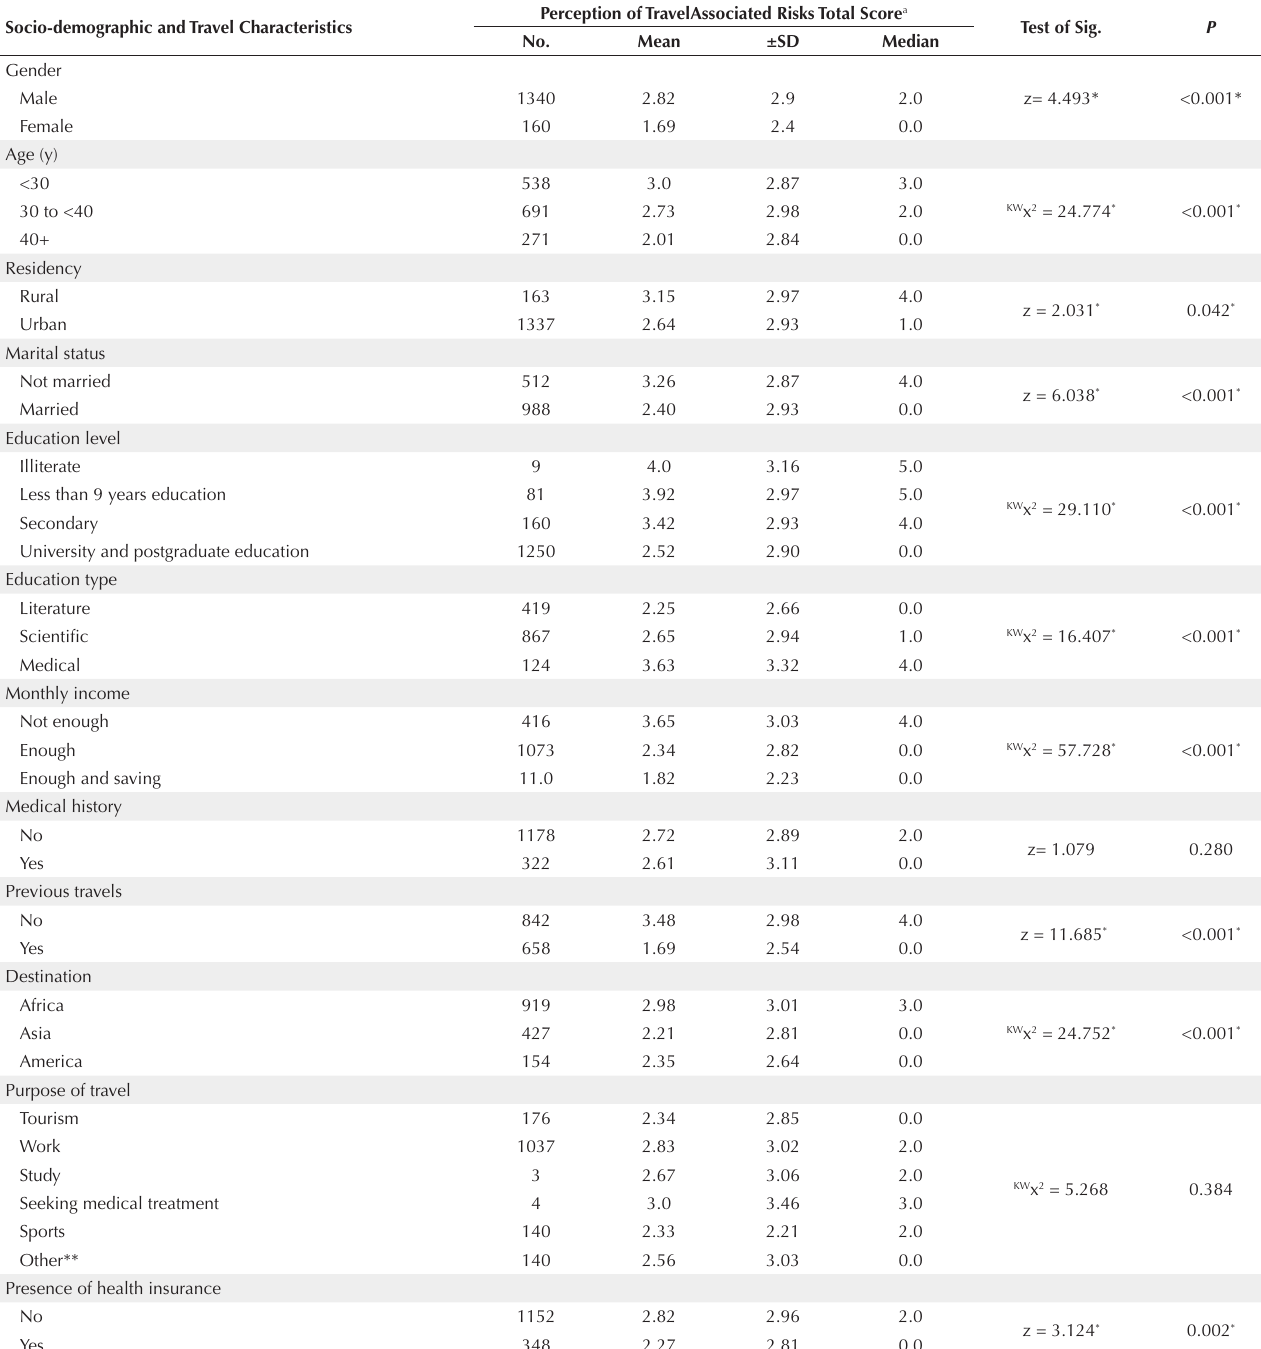
Perception of TravelAssociated Risks Total Score a